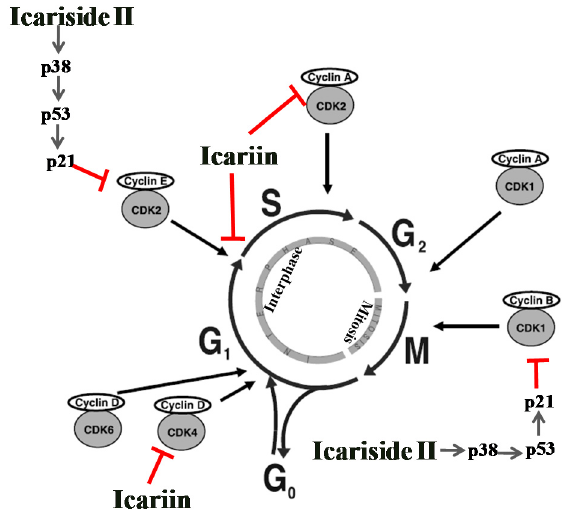
Figure 3. The cell cycle arrest induced by icariin and icariside II. Icariin and icariside II stimulate cell cycle arrest via suppression of the CDKs and cyclins at different stages, ( ← activation; ⊥ inhibition).